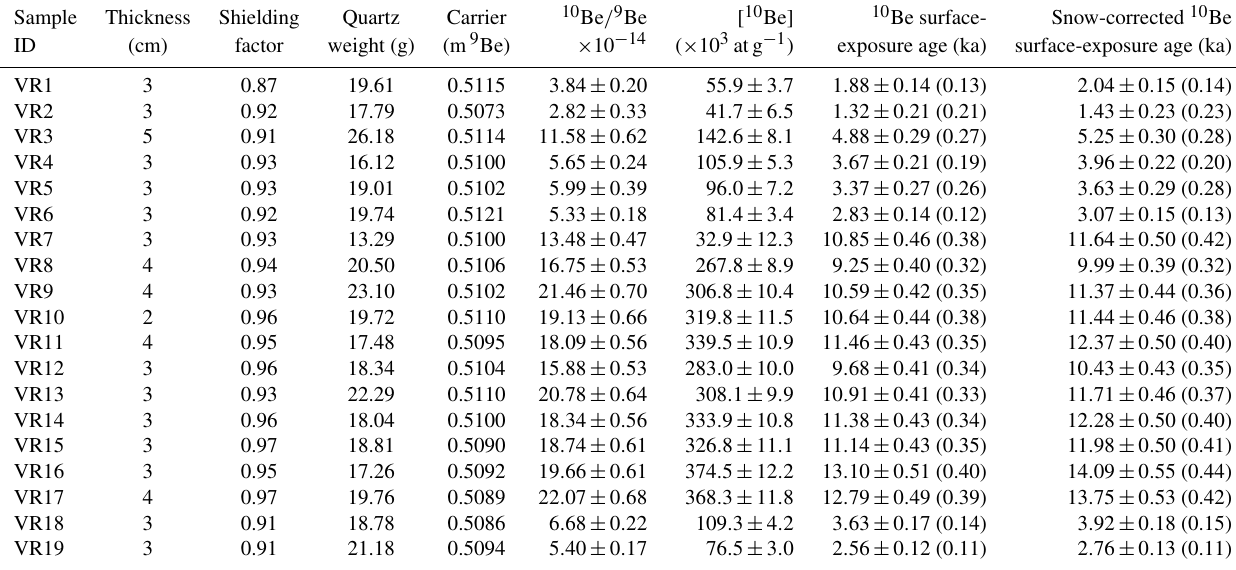
Table 2. Sample details, analytical data related to 10 Be measurements and surface-exposure ages for the rock glacier system of the Vallon de la Route (Combeynot Massif, France), and inputs for the CREp (Cosmic Ray Exposure program) calculator (https://crep.otelo.univ-lorraine. fr/, last access: 3 March 2022; Martin et al., 2017). We used the production rate (4 . 16 ± 0 . 10atg − 1 a − 1 ) derived by Claude et al. (2014) at the Chironico landslide site. The 10 Be surface-exposure ages are presented with ± 1 σ external error and ± 1 σ internal error (in brackets). Shielding correction includes the topographic shielding due to the surrounding landscape, and the dip of the sampled surface is calculated with the CRONUS-Earth online calculators (Balco et al., 2008, http://hess.ess.washington.edu/math, last access: 3 March 2022). The density of the rock boulder samples is assumed to be 2.75gcm − 3 . The 10 Be concentrations were corrected with a blank 10 Be / 9 Be ratio of 6 . 28